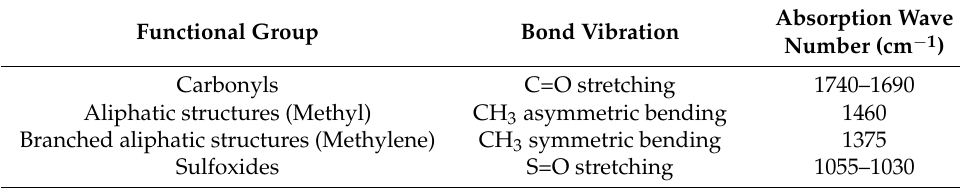
Table 2. Absorption wavenumbers of functional groups.